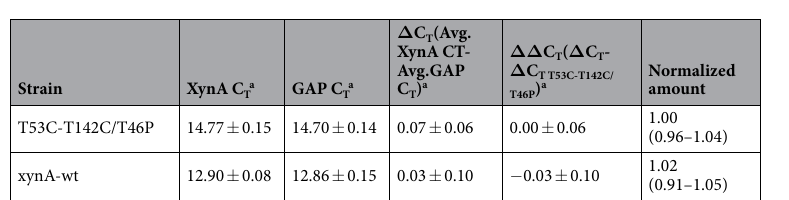
Table 2. The copy number of xynA-wt and T53C-T142C/T46P in P. Pastoris genome. a Values are means ± standard deviation. (n =